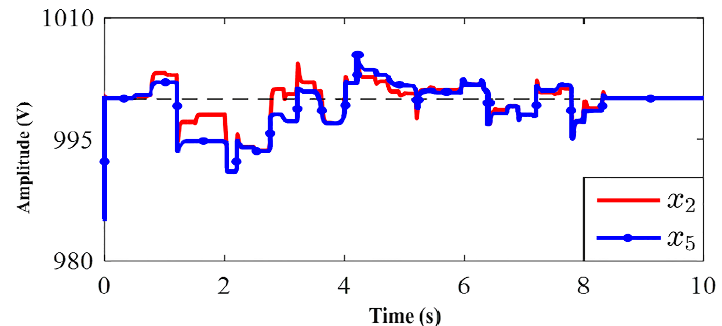
Figure 5. Voltage of C 1 and C 4 Capacitors in the presence of state-dependent Riccati equation (SDRE) controller.